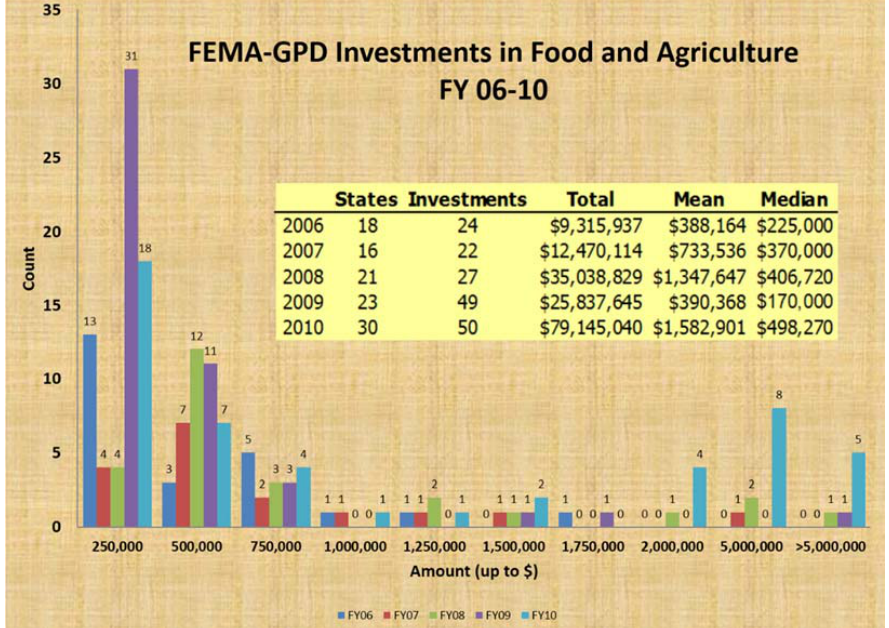
Figure 1. Summary of the number of States and projects funded to support